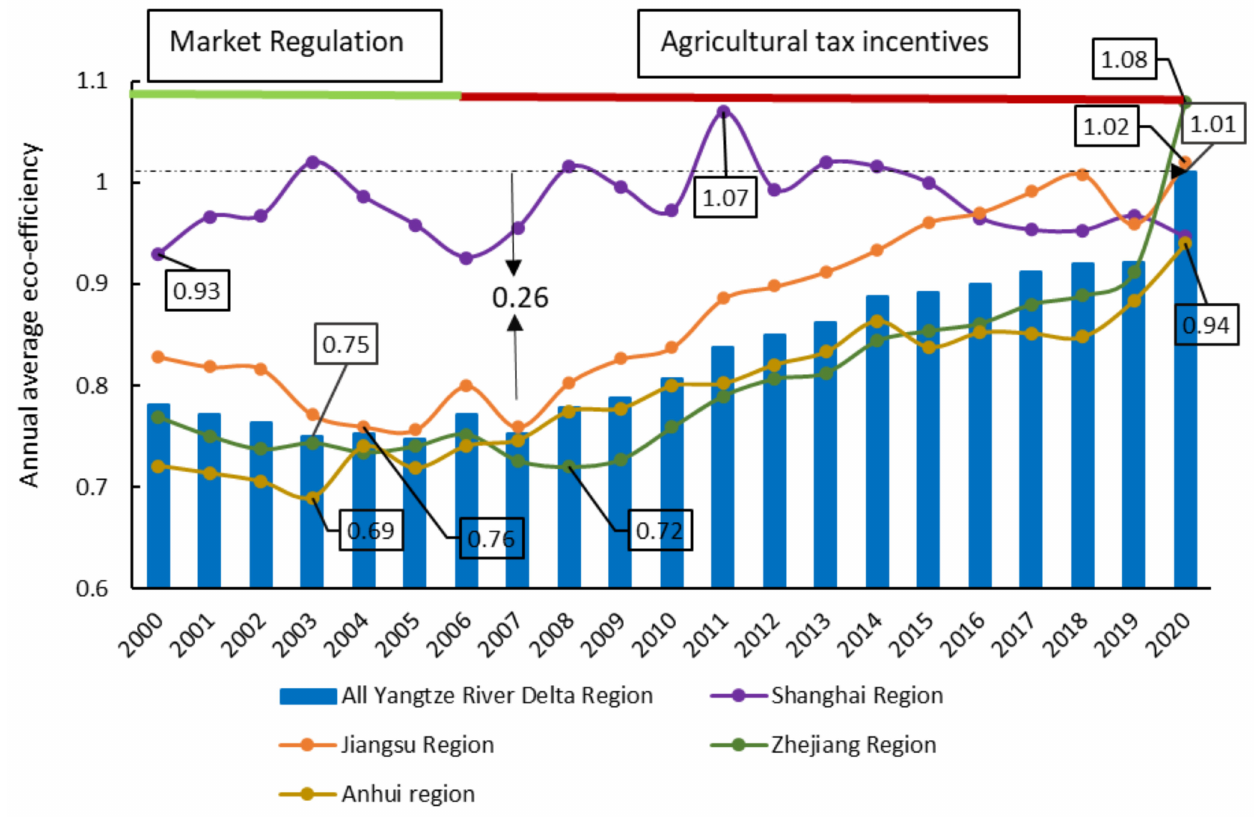
Figure 2. Trends in the time variation of AEE in the YRD region from 2000 to